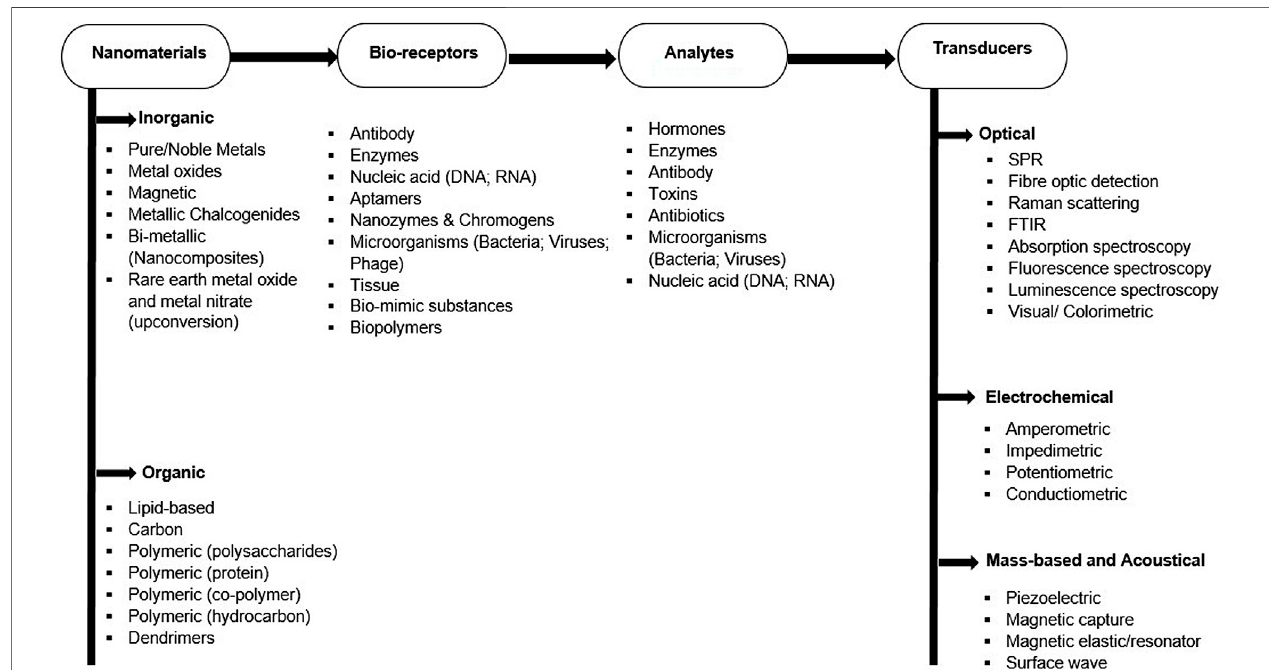
FIGURE 1 | Basic components of nanotechnology-biosensor-based techniques.